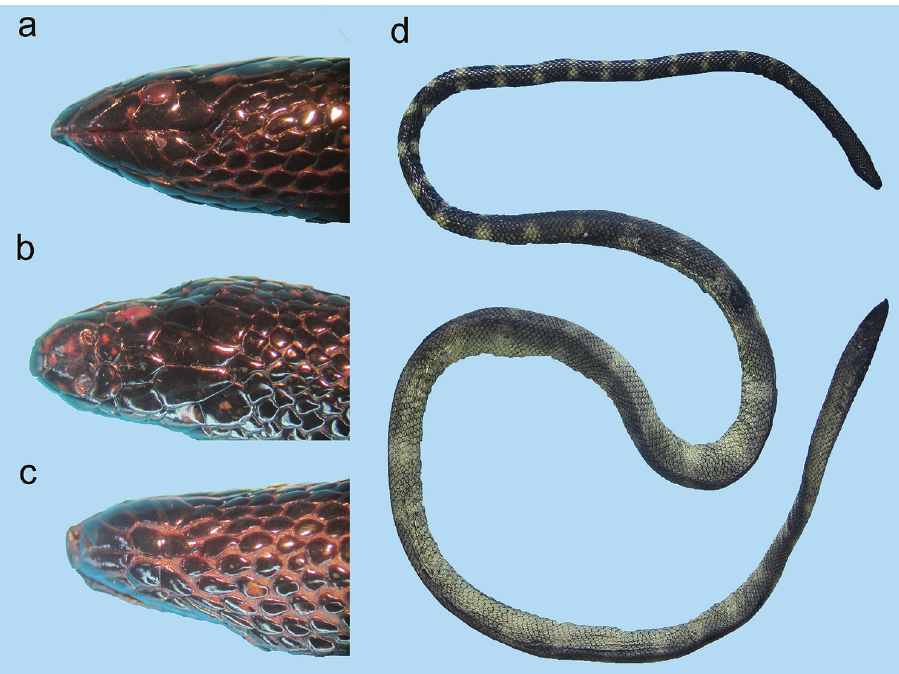
Figure 24. Microcephalophis gracilis : a lateral view b dorsal view, and c ventral view of head d body. HD.36), TL 900, SVL 820, HL 12.2, HW 5.1, GL 9, SNL 3.6, NEL 1.7, ND 22, GBD 58, NSL 6, NSR 18, BSR 31, NV 231, NB 51; (ZMSBUK.HD.37), TL 957, SVL 870, HL 12.5, HW 5.7, GL 8.5, SNL 3.5, NEL 1.4, ND 20, GBD 50, NSL 6, NSR 19, BSR 32, NV 264, NB 46; (ZMSBUK.HD.38), TL860, SVL 787, HL 12.3, HW 5.4, GL 7.7, SNL 3, NEL 1.5, ND 20, GBD 60, NSL 6, NSR 19, BSR 29,